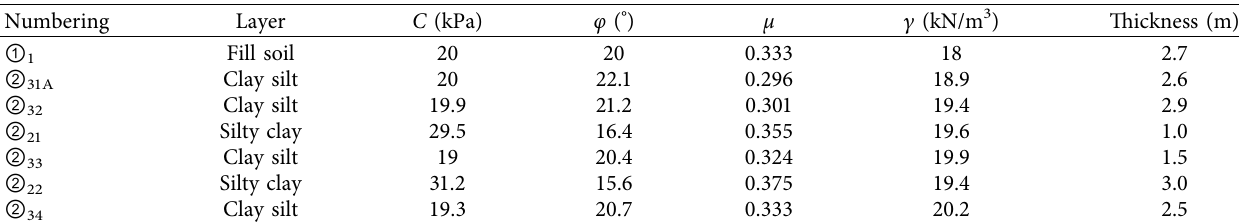
Figure 2: Shield crossing geological section. Table 1: Parameters of soils.